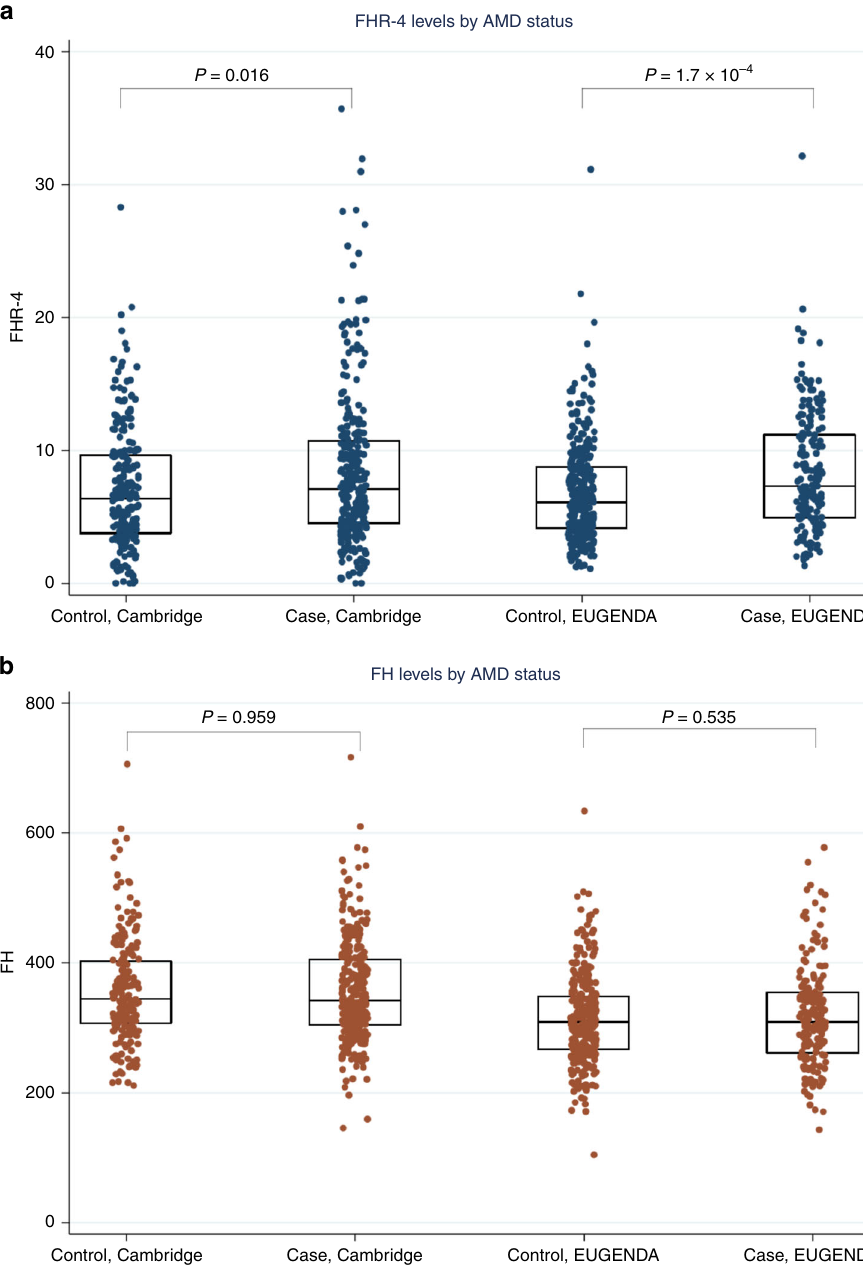
Fig. 1 Systemic FHR-4 levels are elevated in AMD patients. a shows box plots (and corresponding data points) of FHR-4 levels measured in two separate AMD cohorts: Cambridge (plasma from 214 controls and 304 late AMD cases) and EUGENDA (serum from 308 controls and 180 late AMD cases). AMD patients show statistically signi fi cantly elevated FHR-4 levels compared to controls. Geometric mean FHR-4 levels were: Cambridge, 5.5 µ g ml − 1 in controls vs. 6.6 µ g ml − 1 in cases; EUGENDA, 6.0 µ g ml − 1 in controls vs. 7.2 µ g ml − 1 in cases. These differences remained signi fi cant after adjustment for sex, age, batch effects and fi rst two genetic principal components ( P value = 0.018 and 8.4 × 10 − 5 for Cambridge and EUGENDA, respectively; Wald test). b shows box plots (and corresponding data points) of FH levels measured in the same samples, where no statistically signi fi cant difference between cases and controls was observed: Cambridge, 349.0 µ g ml − 1 in controls vs. 348.6 µ g ml − 1 in cases; EUGENDA, 304.7 µ g ml − 1 in controls vs. 308.7 µ g ml − 1 in cases. Each box plot depicts median value (central line), fi rst quartile (lower bound line) and third quartile (upper bound line). Source data are provided as a Source Data fi